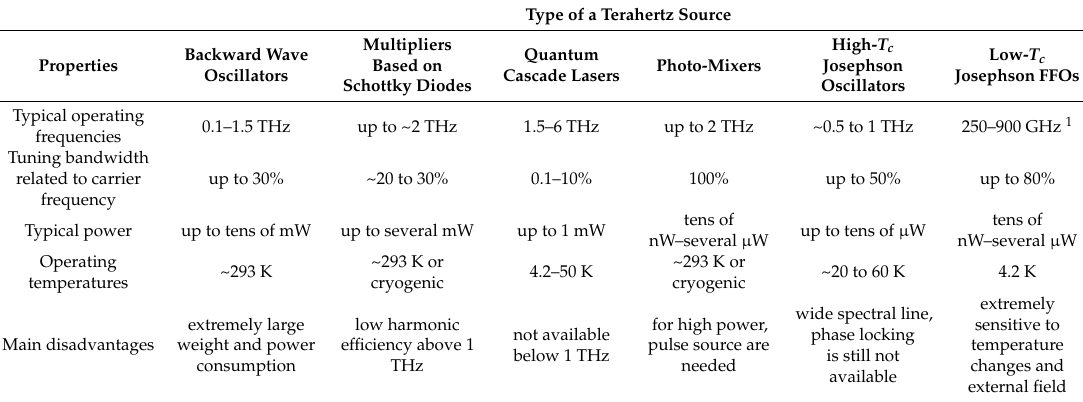
Table 1. Typical characteristics of di ff erent types of THz